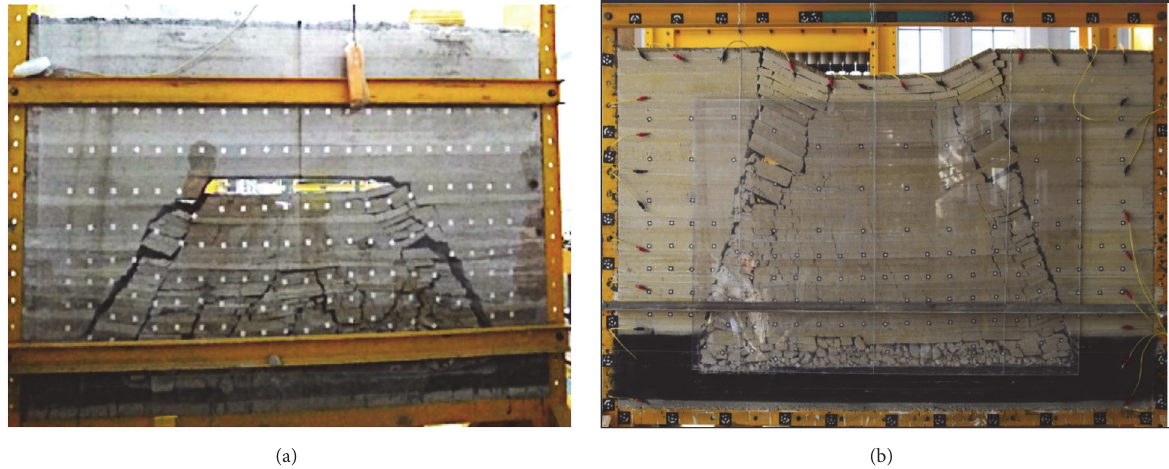
Figure 1: Results of analogous experiments conducted in different climate. Experiments conducted in Urumqi (a) and Xuzhou (b) in June.